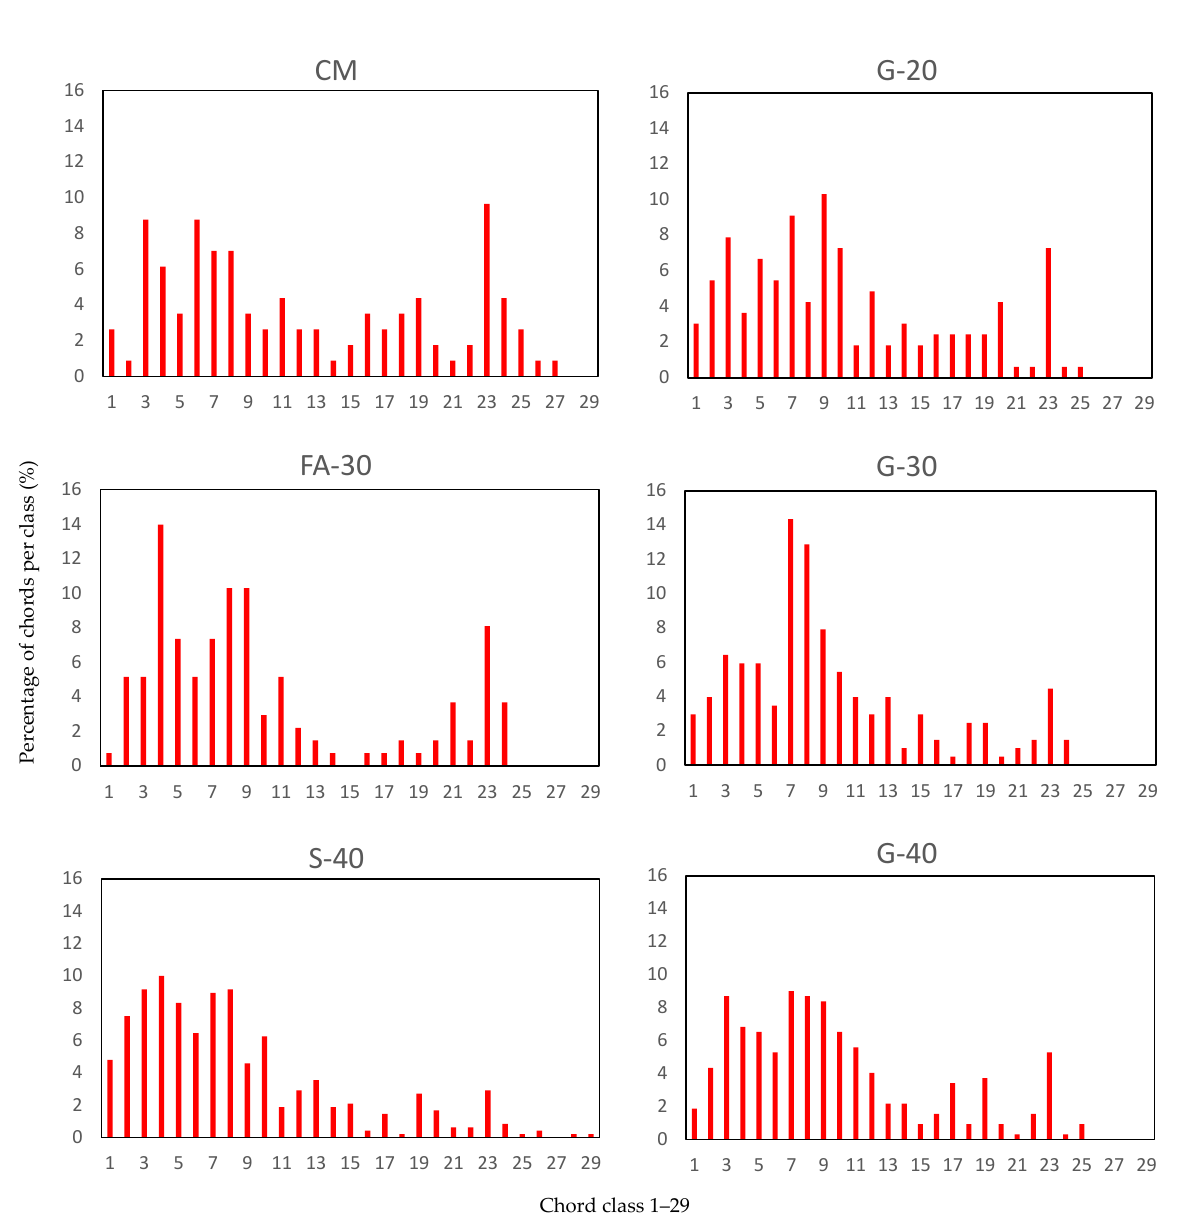
Figure 14. Classification of the air voids in 29 classes from 0 to 4000 μm (see Appendix A). In Table 7, α is specific surface of the air voids, P is paste content by volume calcu- lated from the mix design proportions, A is air void content (%) calculated by the linear traverse method, R represents the ratio of paste and air void content ( P/A ), L is spacing factor, and formulas are given in Appendix A.